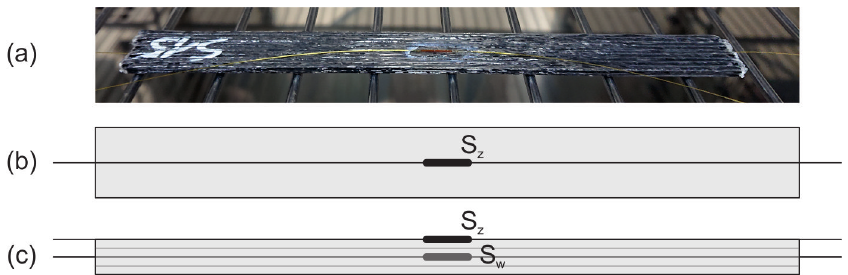
Figure 1. Sample: ( a ) Photograph and scheme, ( b ) top view of the sample, and ( c ) cross-section of the sample; S z —FBG sensor glued on the surface, S w —FBG sensor embedded.